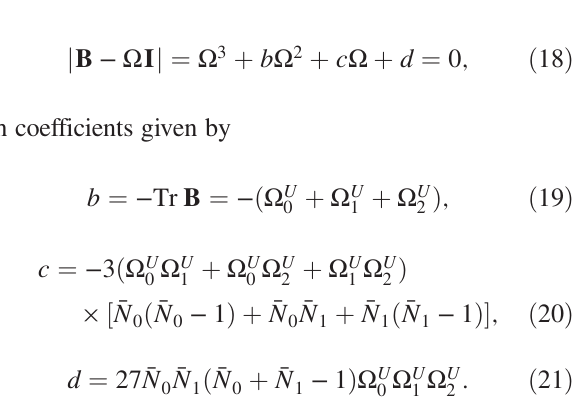
¼ 12 . 7 mA: th , where τ is the y y